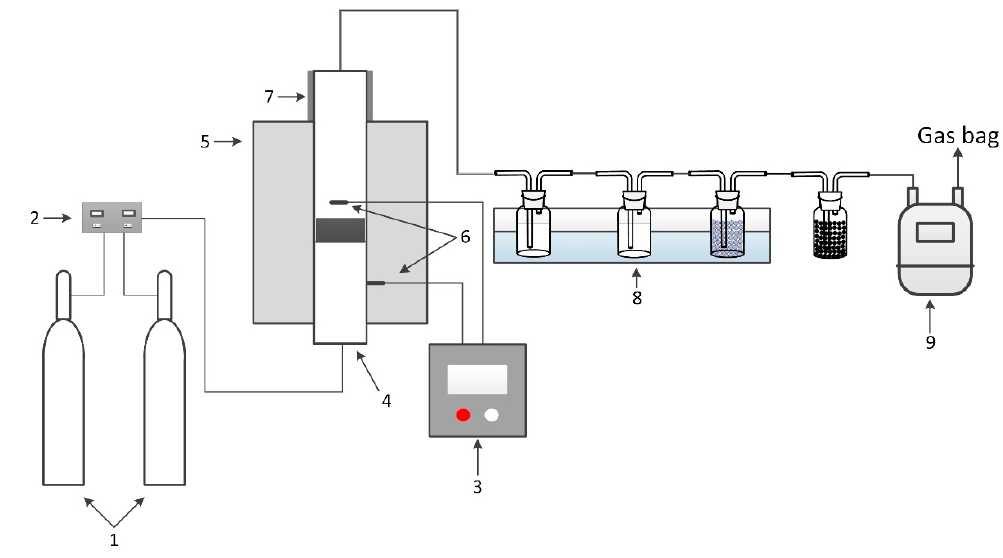
Figure 1. Diagram of the experimental facility: (1) gas cylinder, (2) mass flowmeter controller, (3) temperature controller, (4) quartz tube, (5) tubular furnace, (6) thermocouples, (7) heating tape, (8) ice water bath, (9) gas meter.